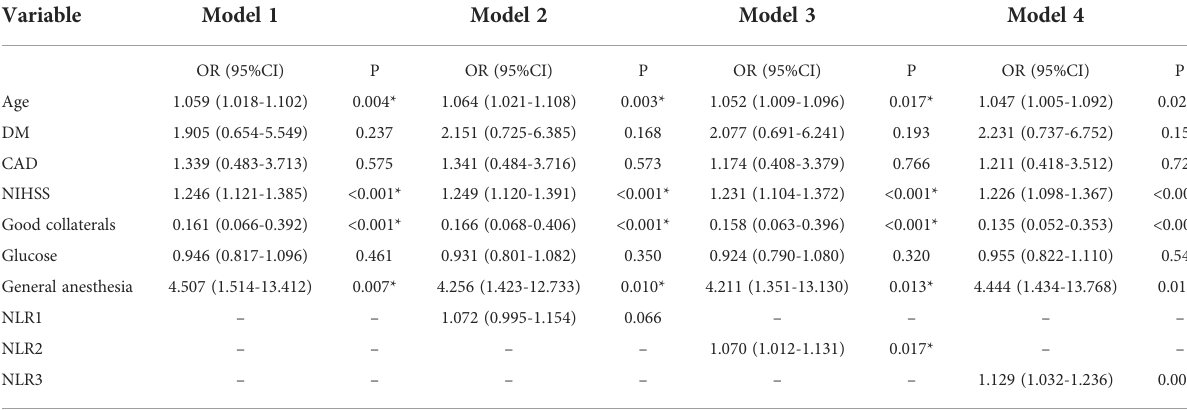
TABLE 2 Independent predictors of unfavorable outcome despite complete reperfusion.